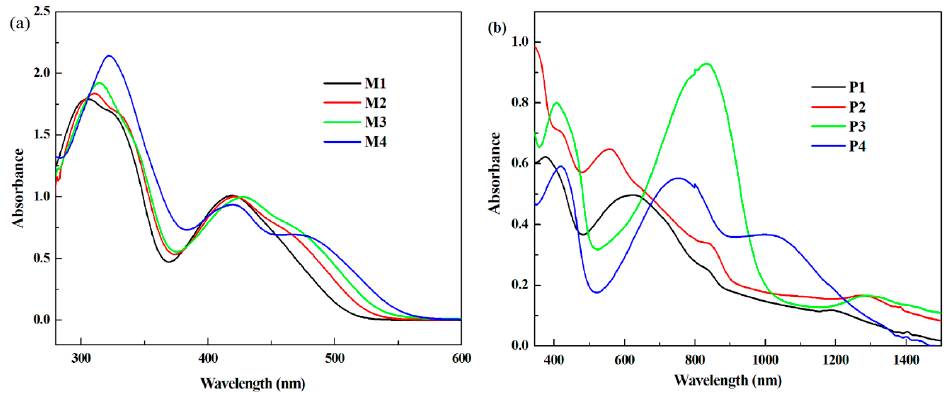
Figure 6. UV-vis spectra of the monomers and the polymers: ( a ) M1, M2, M3 and M4 (dissolve in DCM); and ( b ) P1, P2, P3 and P4 (deposited on ITO